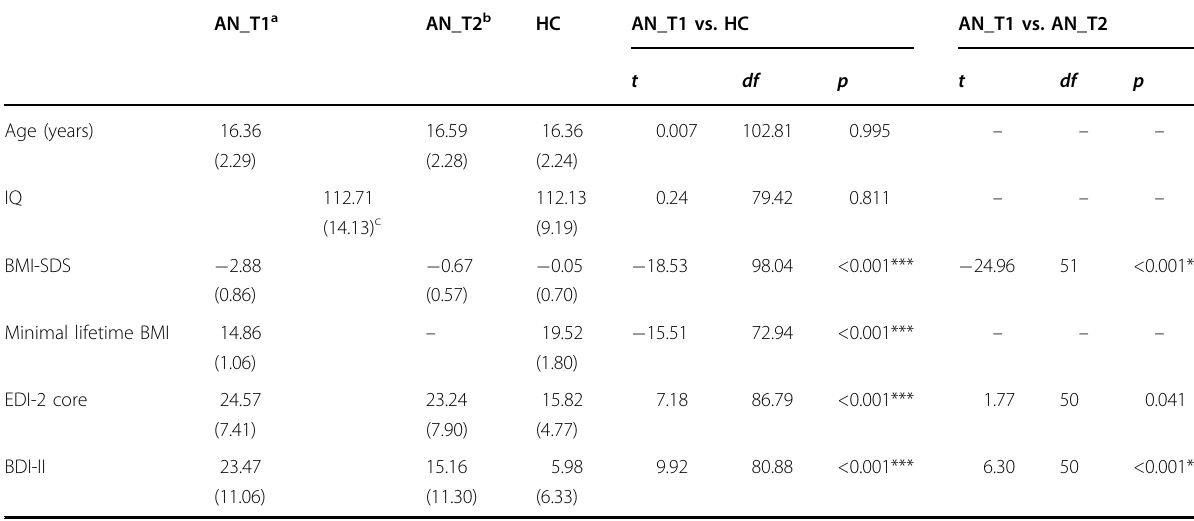
Table 1 Mean values (standard deviation) of sample characteristics and statistics of group comparisons.